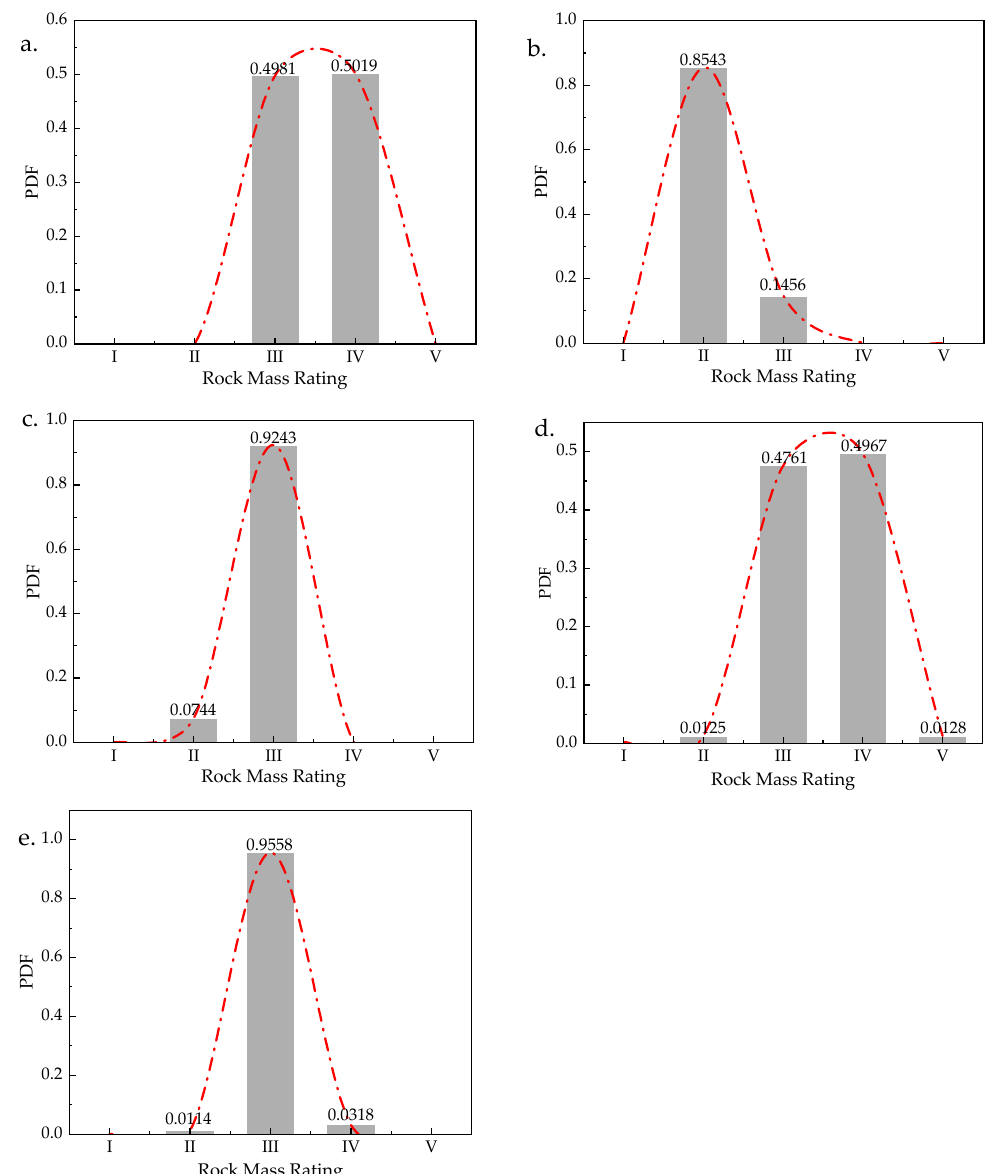
Figure 8. Initial fusion results of each rock mass index ( R 1 – R 5 ). ( a ) Initial fusion result of R 1 . ( b ) Initial fusion result of R 2 . ( c ) Initial fusion result of R 3 . ( d ) Initial fusion result of R 4 . ( e ) Initial fusion result of R 5 . Rock mass index R 2 is rated by the spacing of discontinuities, which is obtained by digital photography, and laser scanning. The excavation face is divided into several